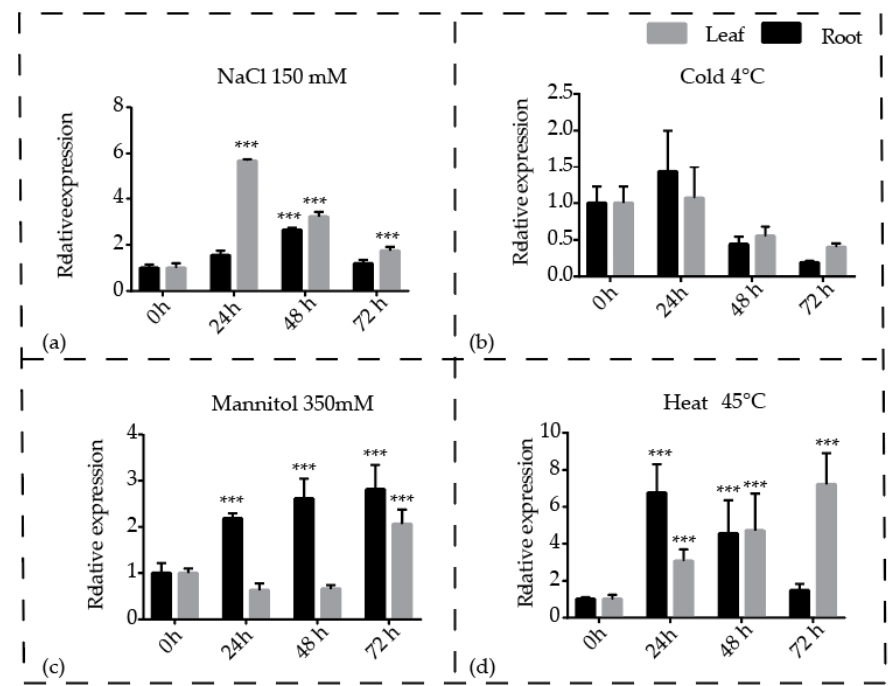
Figure 6. Expression profiles of the pineapple CBL1 gene in response to different stress treatments. qRT-PCR of CBL1 gene in at different time point (0 h, 24 h, 48 h, and 72 h) and samples (leaf and root) after a) salt (NaCl 150 mM), b) cold (4 °C) stress, c) osmotic (Mnnitol 350 mM) stress, and d) heat (45 °C) stress. Data were normalized to EF1a gene. Vertical bars indicate SE and *** indicates significantly different values compared to control treatment ( p < 0.001). All experiments were performed with three technical and three biological repeats.